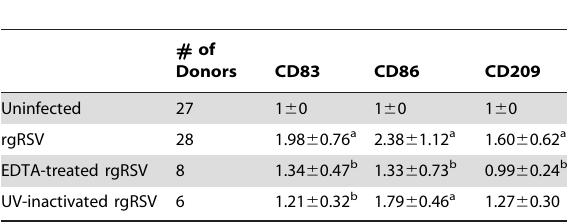
Table 1. Maturation of mDCs After RSV